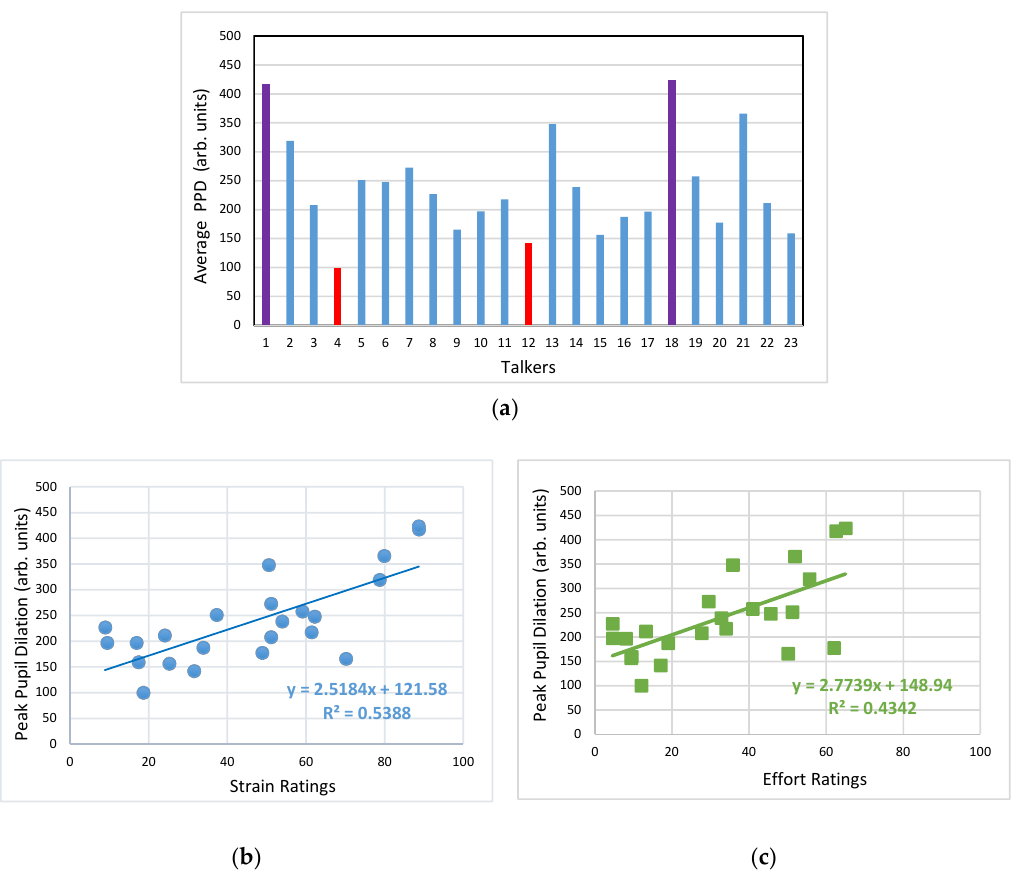
Figure 5. ( a ) Peak pupil dilation (PPD) values extracted from averaged pupil tracks associated with each talker stimulus. Talker samples that resulted in the two highest and lowest PPD values associated are highlighted in purple and red colours, respectively. ( b ) Scatter plot between the averaged perceptual ratings of strain and the PPD values extracted from averaged pupil tracks, along with the linear regression fit to the data. ( c ) Scatter plot of PPD values extracted from average pupil tracks with the averaged perceptual ratings of listening effort, along with the linear regression fit to the data.